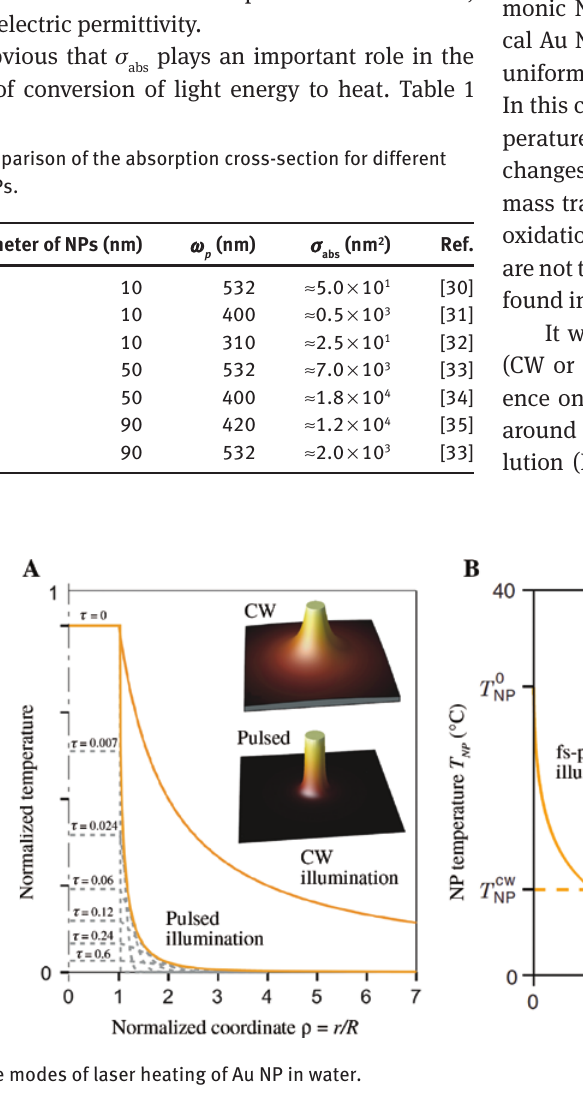
is used in case of tr